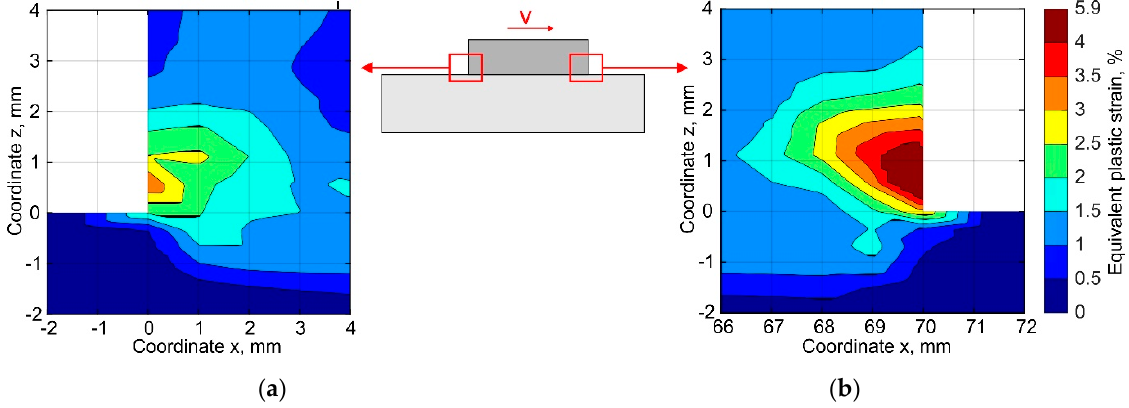
Figure 12. Distribution of the residual transverse stresses σ y in ( a ) the cross-section near the buildup end and ( b ) the middle part of the buildup.